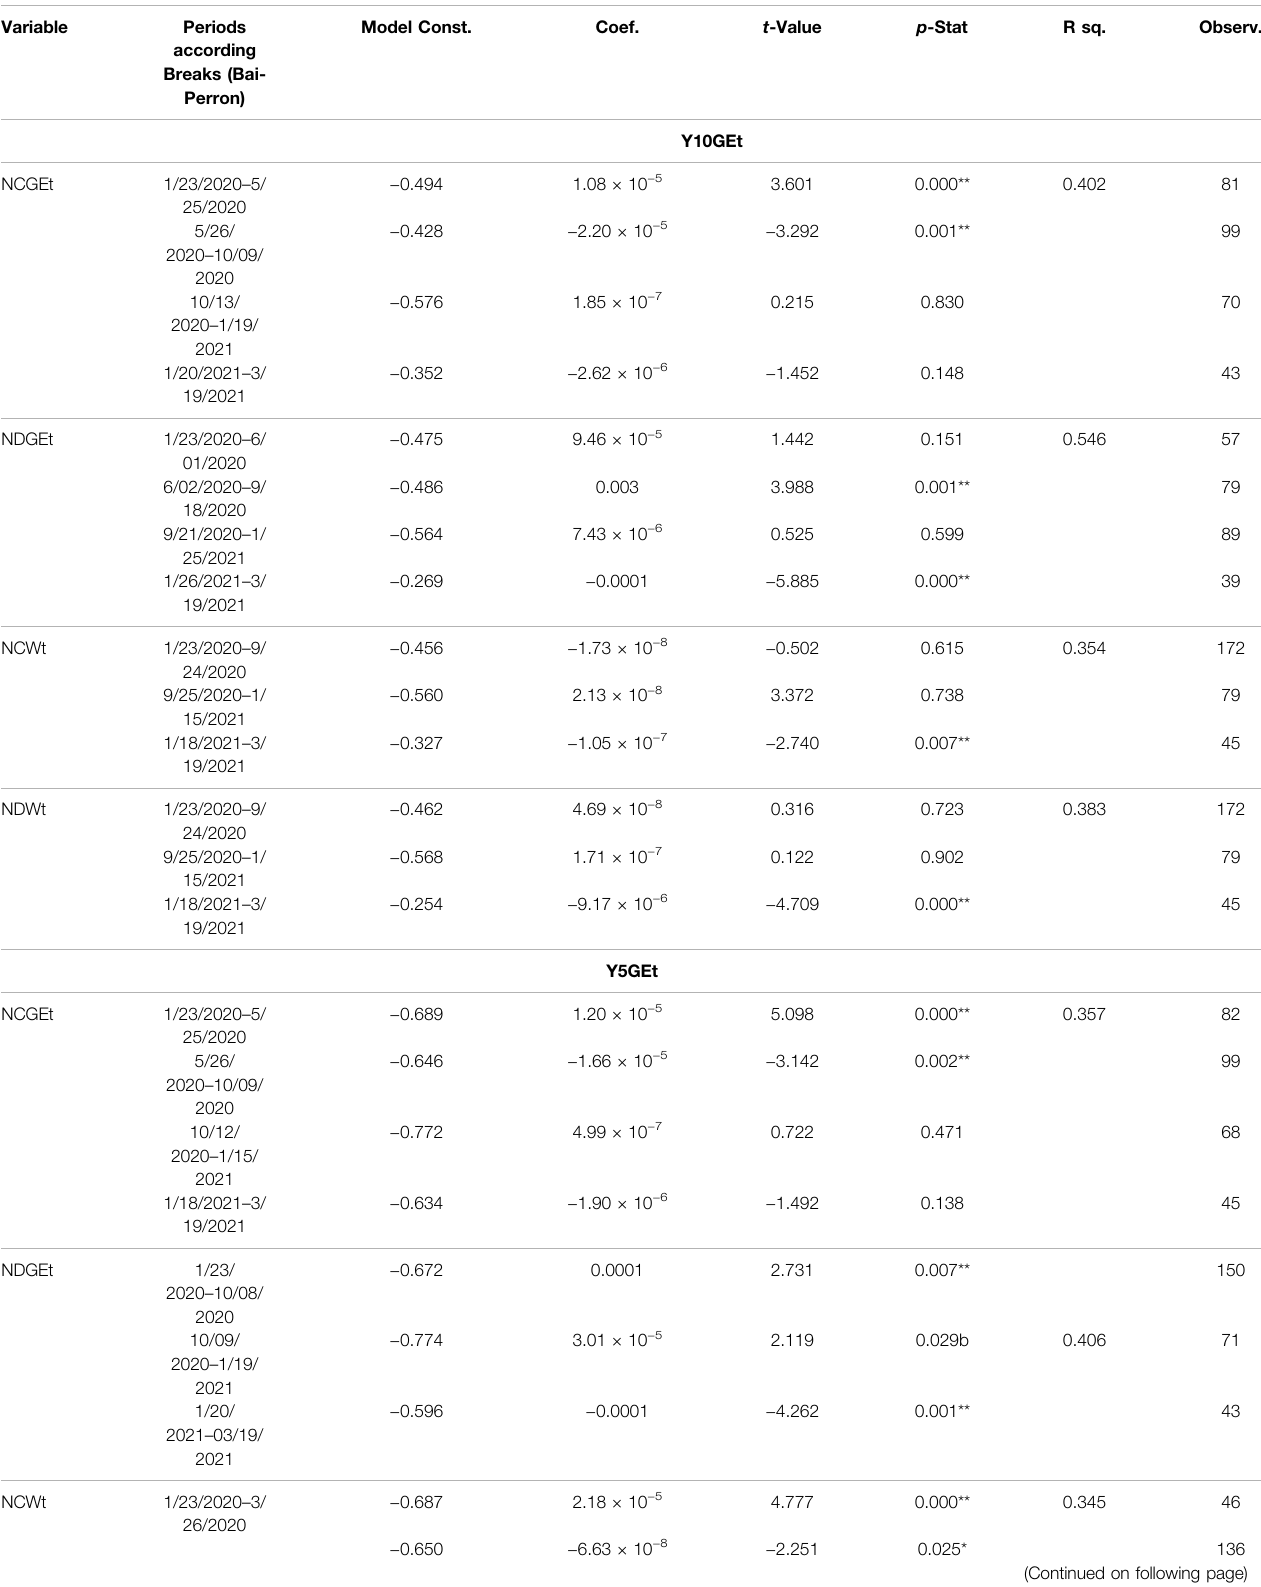
TABLE 2 | Linear regression (Least Squares with Breakpoints) models for COVID-19 effect on Germany government bond yields. Variable Periods Model Const. Coef. t -Value p -Stat R sq. Observ. according Breaks (Bai- Perron)